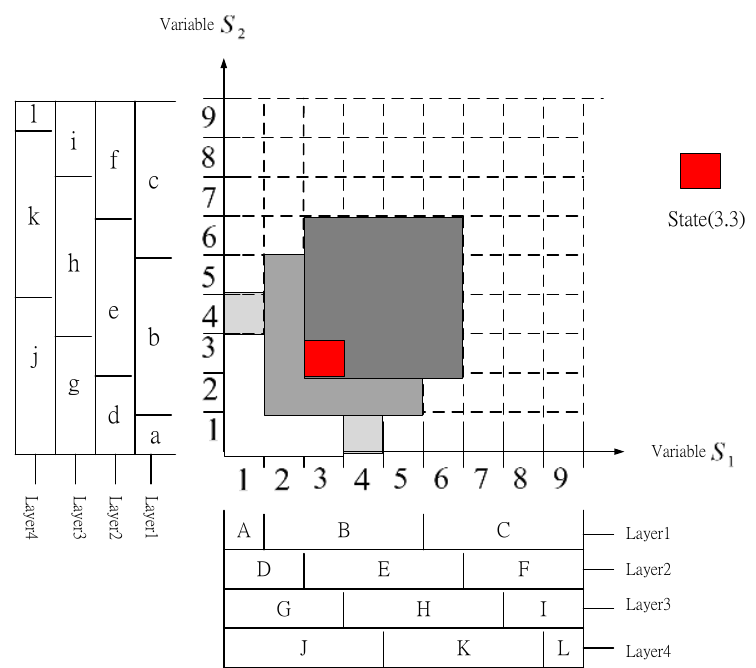
Figure 3. The mapping structure of the two-dimensional CMAC.